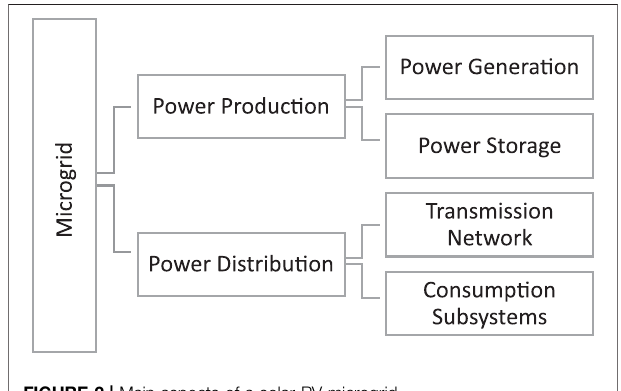
FIGURE 2 | Main aspects of a solar PV